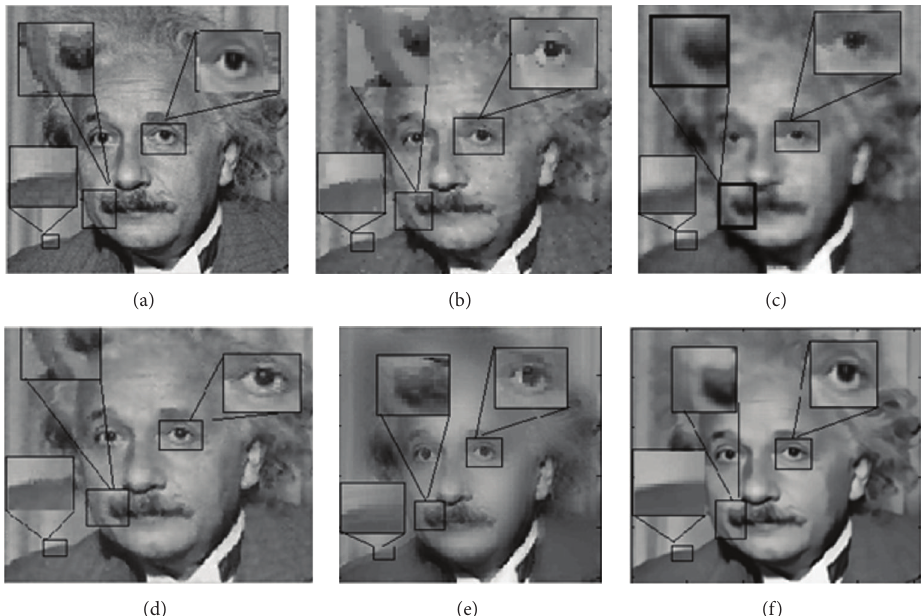
Figure 17: Comparison of various edge-preserving filters implemented using hardware on the natural grayscale image Einstein of size 150 × 150 measured for similar number of iterations. (a) Original image. (b) Direct implementation of the anisotropic diffusion filter (software implementation). (c) Output of the bilateral filter realized using FPGA. (d) Output of nonlocal means filter. (e) Trilateral filter output. (f) Output of our implementation of optimized anisotropic diffusion filtering using a novel hardware design. Note that the fine boundary transitions in the moustache area (see zoomed insets) are clearly visible in our implementation in (f) unlike others which is clear from the visual experience. Similarly, the zoomed portions of the left eye show the clear distinctions of the lower and upper lid (also holds the contrast information); moreover, the magnified area of the neck portion also shows a sharp transition. All the comparisons should be done keeping the original image in (a) in mind as the reference image. The PSNR difference is as shown in Table 2.